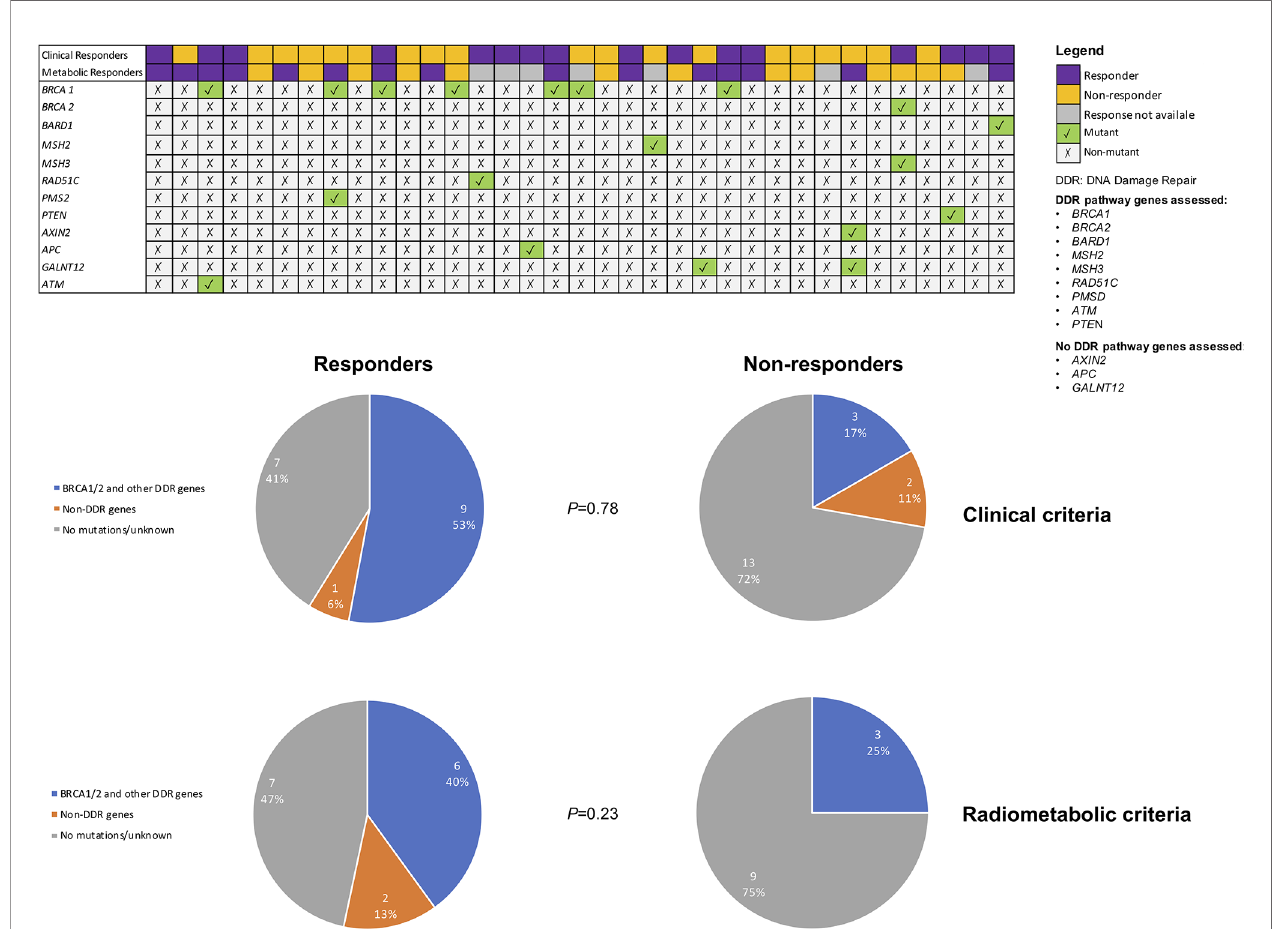
FIGURE 5 | Mutational status according to clinical and radiometabolic response status. Only mutant genes are